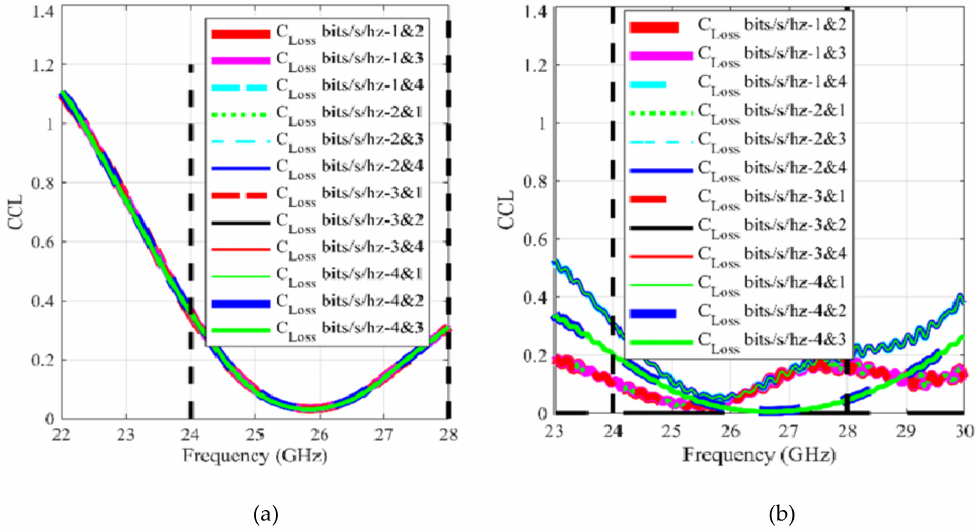
Figure 23. The measured and simulated CCL for mmWave MIMO configuration: ( a ) simulated CCL; ( b ) measured